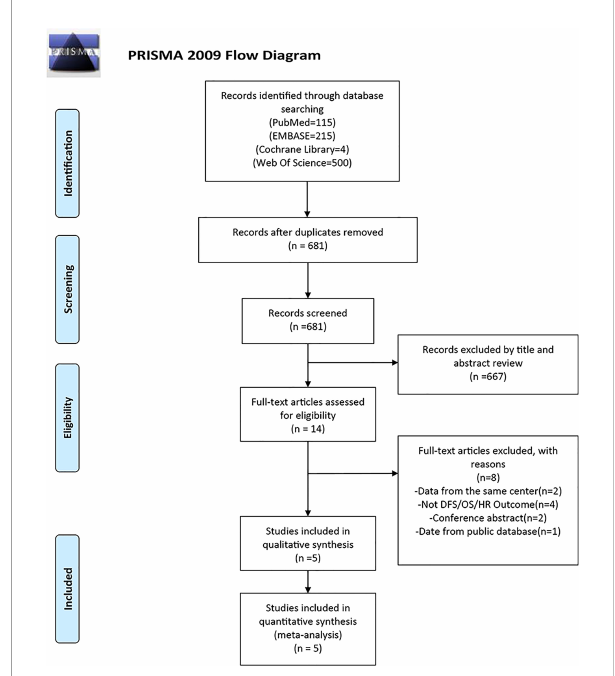
FIGURE 1 PRISMA fl ow diagram of literature retrieval. PRISMA, Preferred Reporting Items for Systematic Reviews and